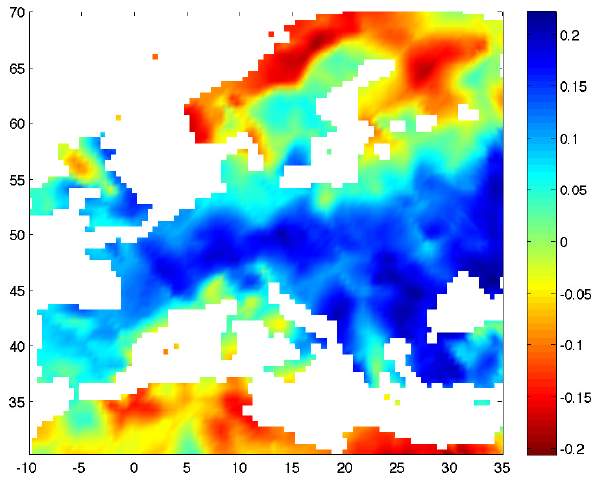
Fig. 3. Same as Fig. 2 but now we correlate a randomized version of the Mann et al. (2000) Nino3 index to the proxy precipitation field. Clearly the coherence observed in the pattern in Fig. 2 is destroyed and moreover the correlations are smaller by a factor of about